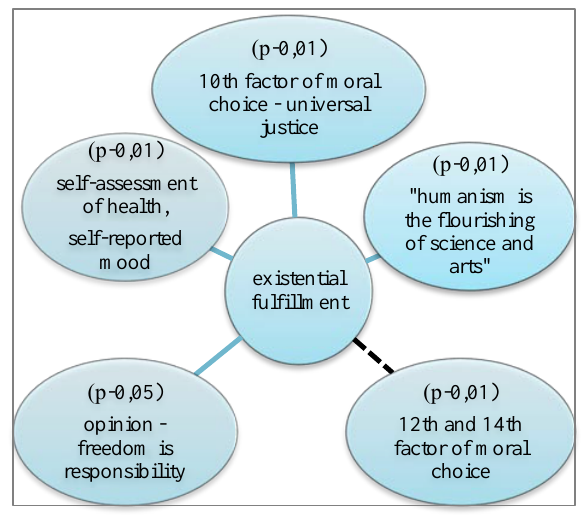
Fig. 12. Correlations with indicators of the scale of existential fulfillment (G) The